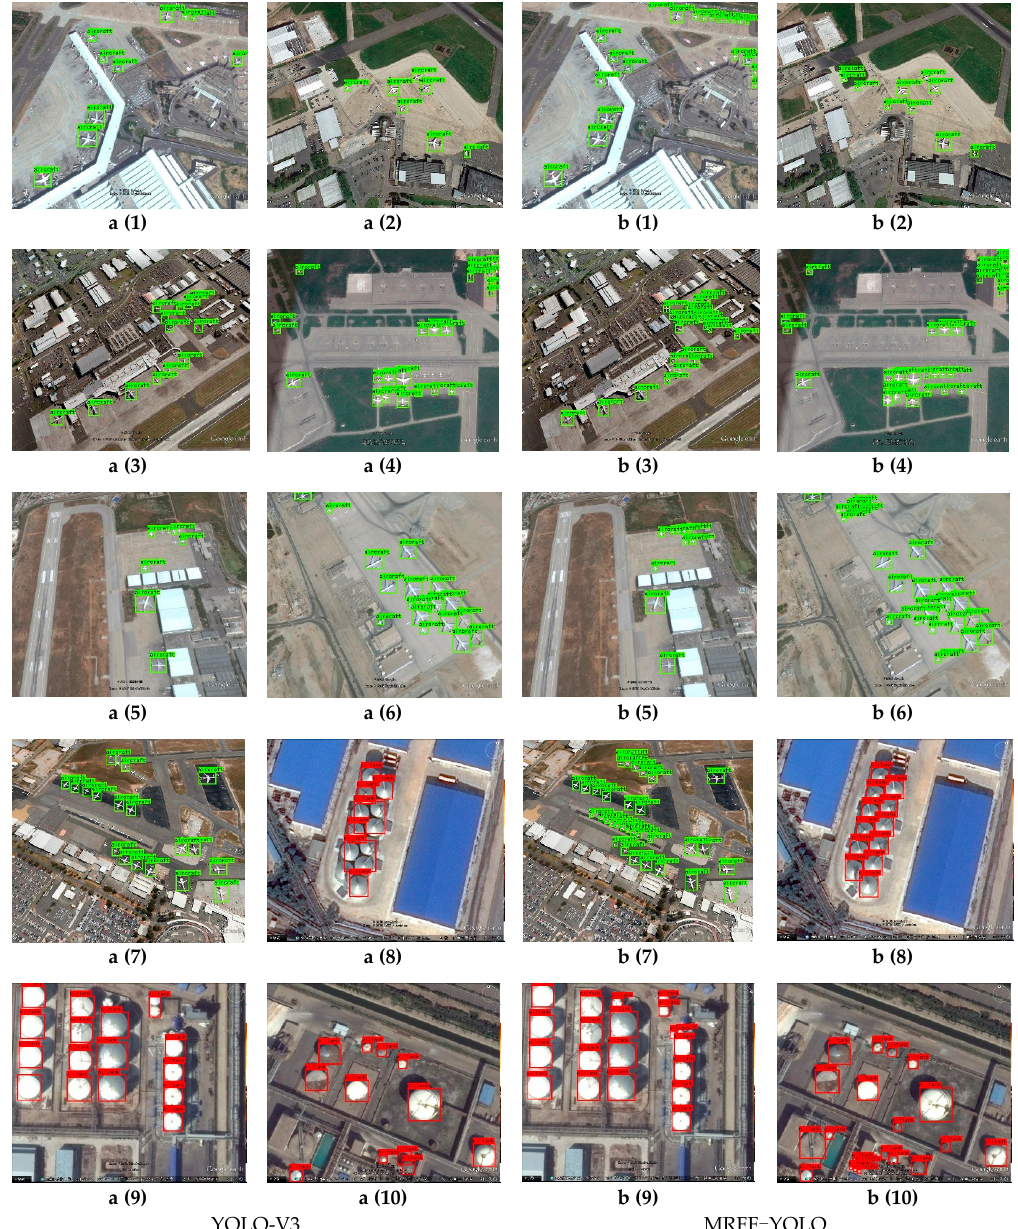
Figure 11. The comparison results of YOLO-V3 and MRFF-YOLO: (a1)–(a10) the detection results of YOLO-V3; (b1)–(b10) the detection results of MRFF-YOLO.